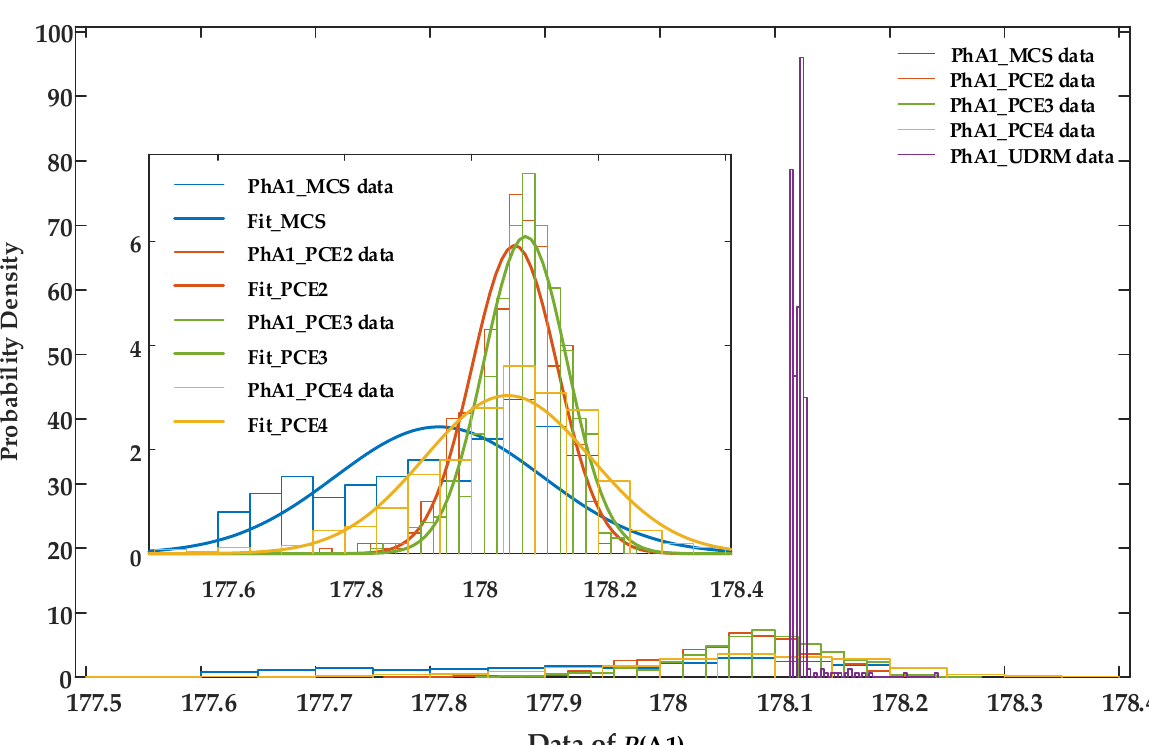
Figure 10. The probability density of the calculated data of P (A1) using the 5 different methods under 50% uncertainty of sheath resistivity under short-circuit fault condition.